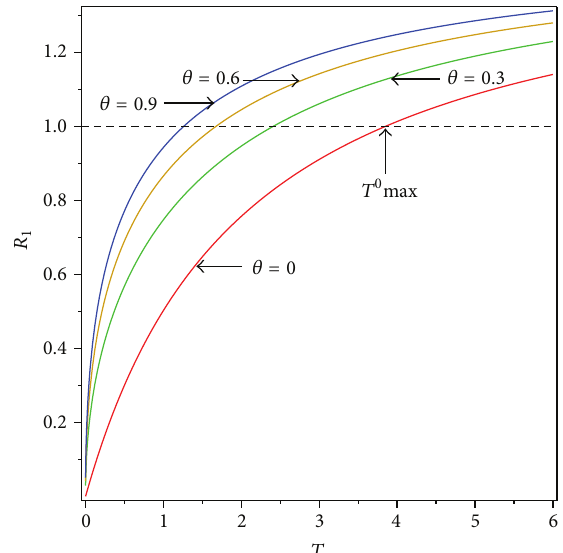
Figure 2: Time series of 𝑆 of system (42) while 𝜃 = 0 .